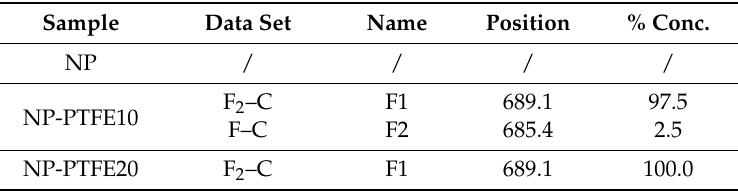
Table 5. F 1s peak fitting result for NP, NP-PTFE10, and